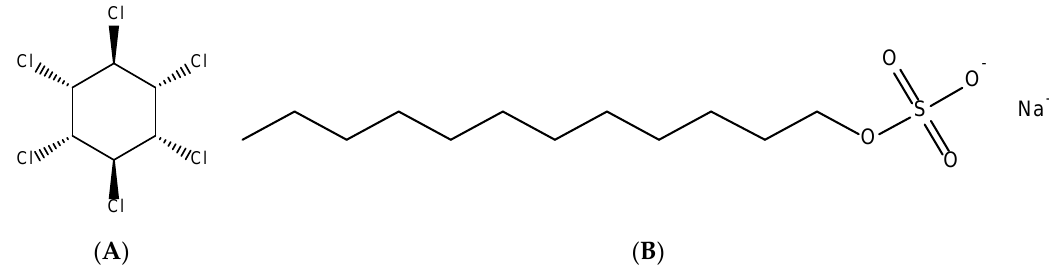
Figure 1. The chemical structures of lindane ( A ) and sodium dodecyl sulfate (SDS) ( B ).